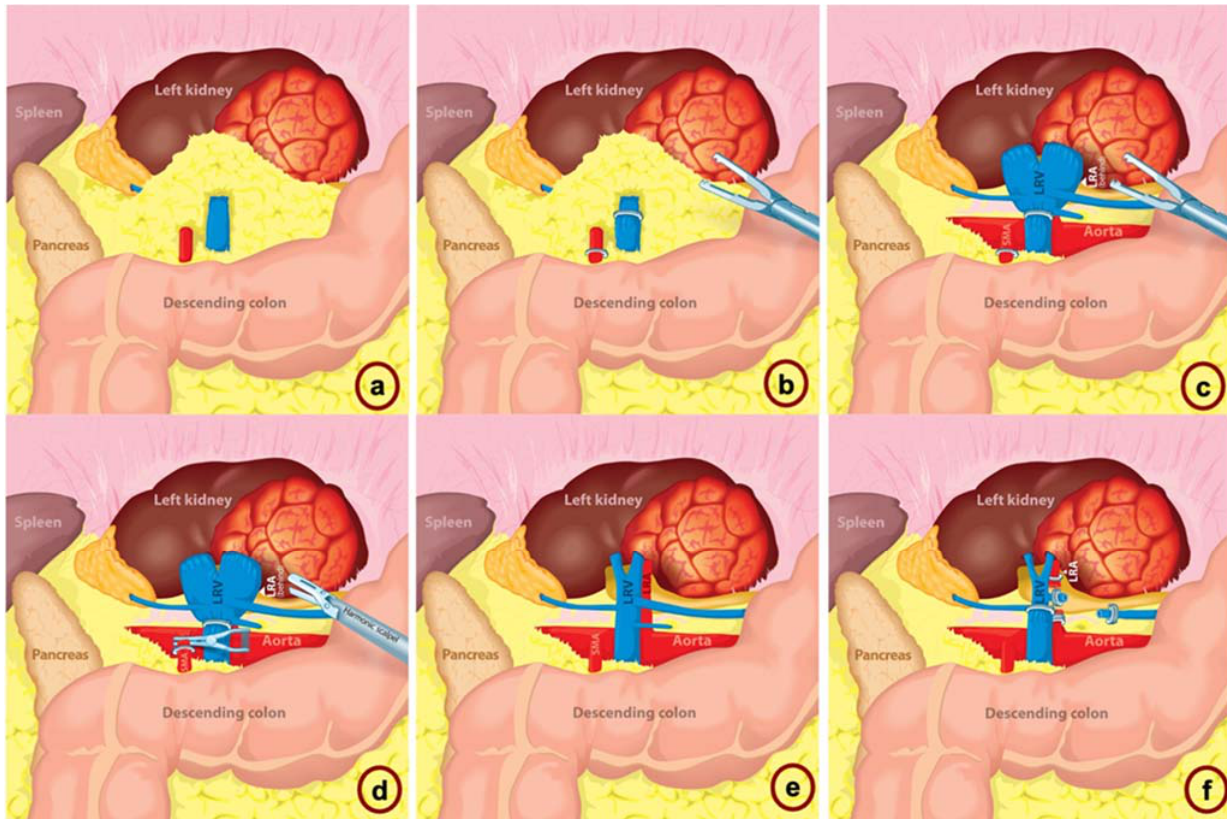
Figure 1. SMA clipping after misidentification as the left renal artery with prompt recognition and management. ( a ): left renal hilum is dissected through a transperineal approach. ( b ): the apparent LRA and LRV are clipped. ( c ): SMA clipped and dilated LRV indicates patent inflow to the kidney. ( d ): a bulldog clamp is placed proximally, and a Harmonic Scalpel is used to remove the clip. ( e ): vascular structures are identified and examined, the true LRA is identified posterior and lateral to LRV, and the SMA is identified anteriorly to the LRV. ( f ): the true LRA is identified and clipped, and the LRV is clipped and collapsed, which indicates no inflow to the kidney. SMA: superior mesenteric artery; LRV: left renal vein; LRA: left renal artery.